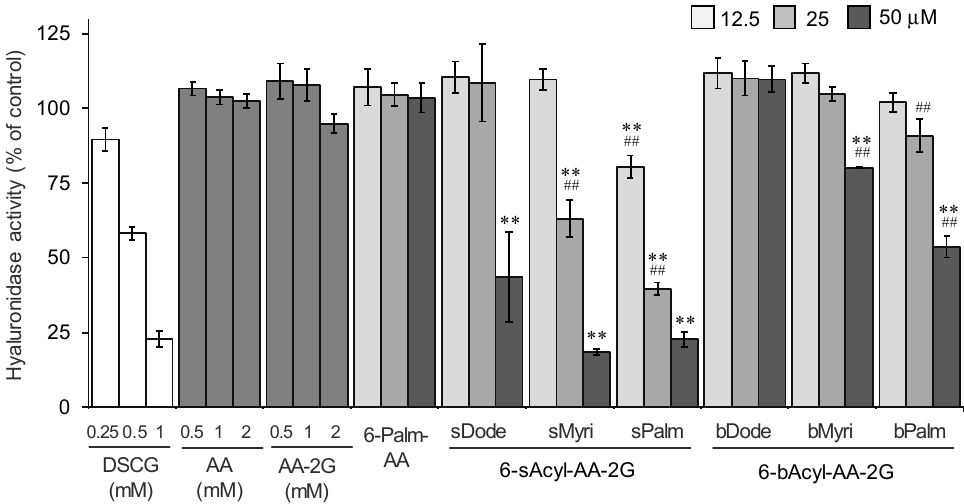
Figure 2. Inhibitory effects of 6-sAcyl-AA-2G and 6-bAcyl-AA-2G on hyaluronidase activity. All data represent means ± SD of three independent experiments. ** p < 0.01, vs. 6-sPalm-AA; ## p < 0.01, 6-sDode-AA-2G vs. 6-sMyri-AA-2G and 6-sPalm-AA-2G, 6-bDode-AA-2G vs. 6-bMyri-AA-2G and 6-bPalm-AA-2G (Dunnett’s test).